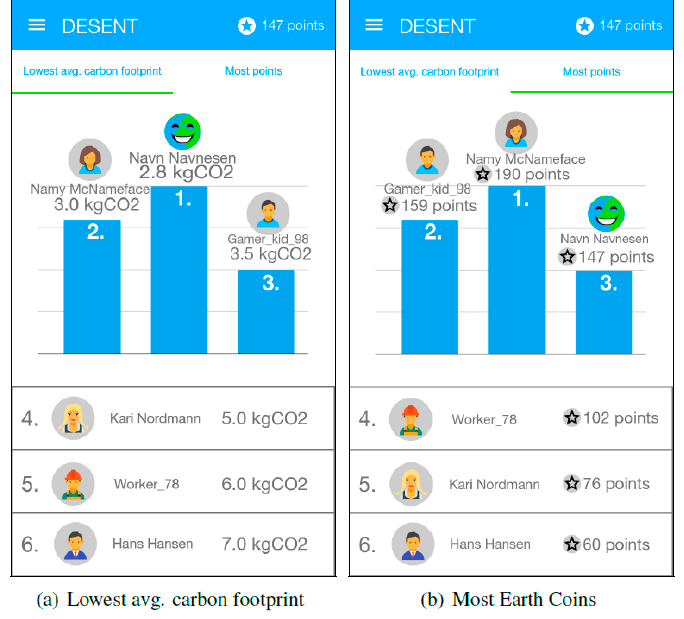
Figure 6. Smiling Earth for Communities showing examples of different ways of showing Leaderboards; ( a ) shows a leaderboard for lowest CO 2 emissions and ( b ) shows a leaderboard for earth coins collected.